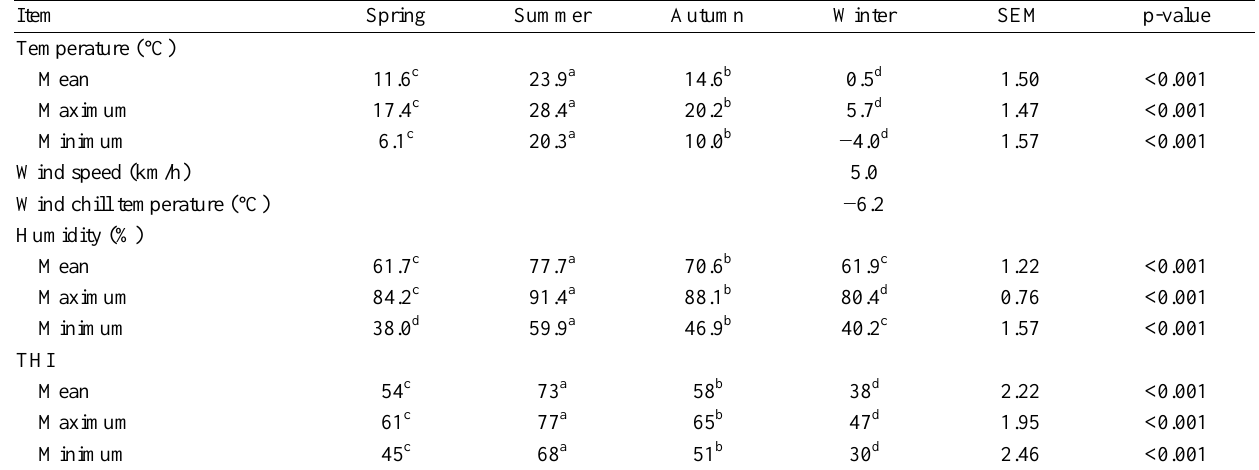
Table 2. Seasonal temperature, relative humidity, and temperature-humidity index (THI) values for 8 years (2006 through 2013) in